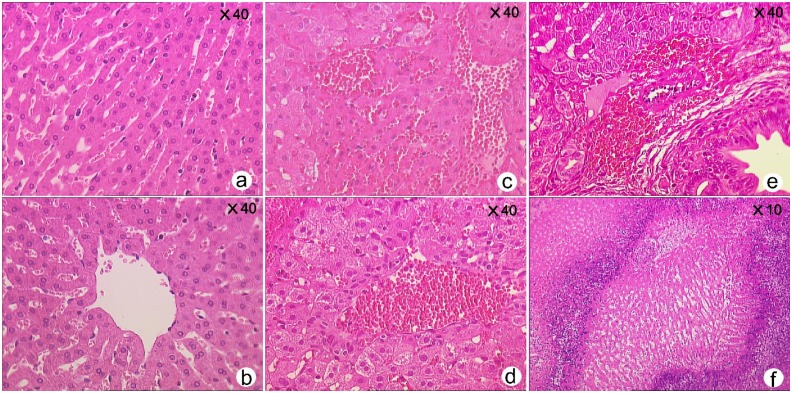
Representative histological HE sections after insonation of the TUS, and, MB groups.Hepatic cord and plate structure were clear, and blood cells were scattered in the sinusoids (a,b); In the MEUS group, hepatocytes swelled, and erythrocytes accumulated in the sinusoids (c), the swollen hepatocytes deformed and compressed the sinusoids and perisinusoidal space. A large number of erythrocytes accumulated in the central veins (d), periportal connective tissue hemorrhaged (e). The targets showed map-like necrosis in the MEUS group after 48 h (f).